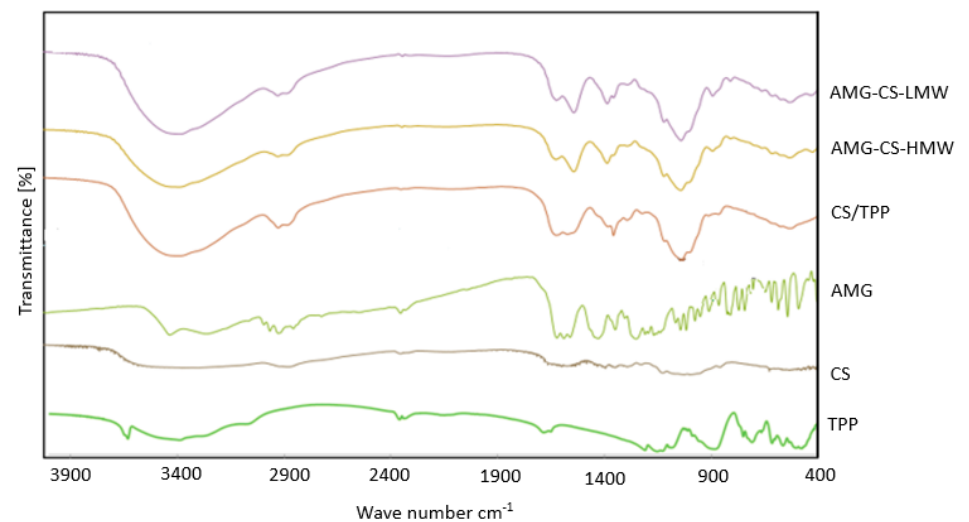
Figure 4. FTIR spectra of AMG, TPP, CS, AMG – CS Nps (HMW), and AMG – CS Nps (LMW).